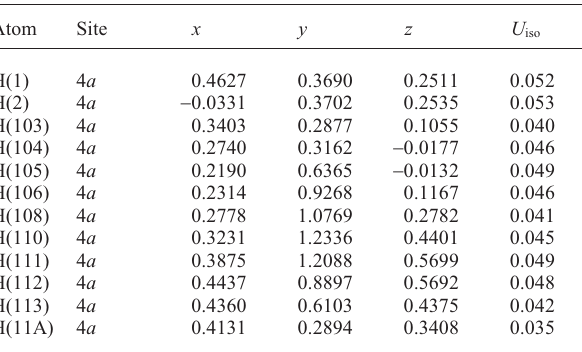
Table 3. Atomic coordinates and displacement parameters (in Å 2 )